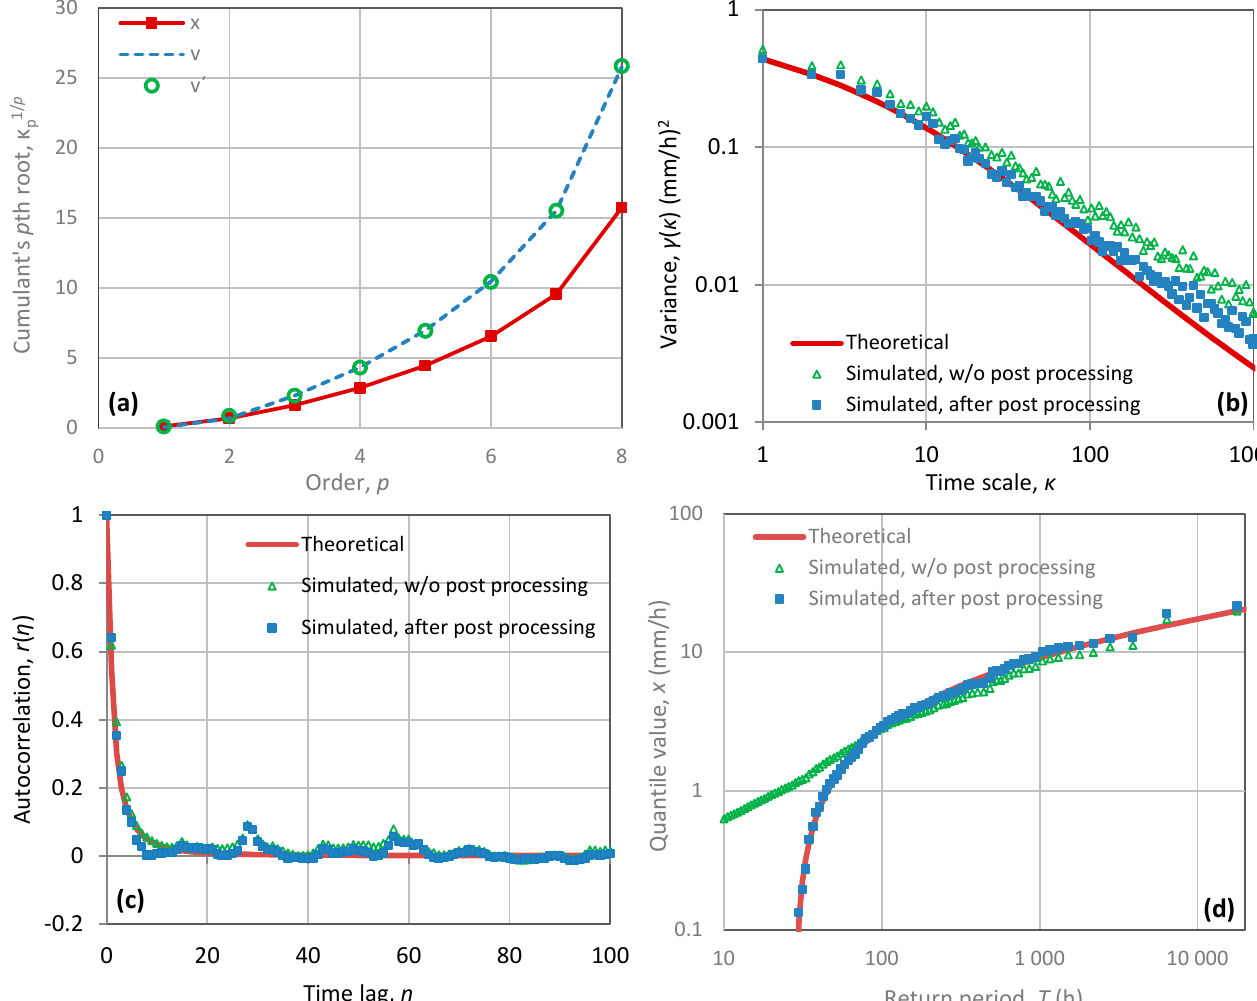
Figure 6. Graphical depiction of the results of the simulation application for a real-world case study for the precipitation process in Bologna at the hourly time scale, modelled as a persistent FHK process with Pareto distribution with discontinuity at zero: ( a ) cumulants; ( b ) climacogram; ( c ) autocorrelogram; ( d ) marginal distribution. For the approximation 𝑣 (cid:3099)(cid:4593) of 𝑣 (cid:3099) , we use a single Pareto distribution and allow a dis- continuity 𝑃 (cid:2869) at 𝑣′ = 0 . For mathematical consistency, the tail index of 𝑣 (cid:3099)(cid:4593) should neces- sarily be 𝜉 = 0.121 , so that the moments of order beyond 1/ ξ = 8.2 be infinite as is the case with the moments of 𝑥 (cid:3099) . The other parameters of the Pareto distribution of 𝑣 (cid:3099)(cid:4593) are calcu- lated by minimizing 𝑒 (cid:2870) in Equation (41), setting 𝑝 (cid:2923)(cid:2911)(cid:2934) = 8 , and are found to be 𝜆 ((cid:3049) (cid:4594) ) = 3.681, 𝑃 (cid:2869) ((cid:3049) (cid:4594) ) = 0.0171 , while the required shift of Equation (42) is negligible ( 𝑐 = 0 ). The cumulants of 𝑣 (cid:3099) (cid:4593) are also plotted in Figure 6a, where it can be seen that they are indistin- guishable from those of 𝑣 (cid:3099) and thus the achieved approximation is very good. Because of the very small value of 𝑃 (cid:2869)((cid:3049) (cid:4594) ) , a very large number of 𝑣 (cid:3099)(cid:4593) (98.3%) will be zero. The nonzero values will determine the locations of rainfall events, i.e., sequences of non-zero 𝑥 (cid:3099) . It is not reasonable to make these locations purely random and for this reason we devised the following procedure. A first model run is done with 𝑃 (cid:2869)((cid:3049) (cid:4594) ) = 1 (no zeros). Subsequently, we find a threshold 𝑐 (cid:2868) so that the fraction of values 𝑥 (cid:3099) that are greater than 𝑐 (cid:2868) equal 𝑃 (cid:2869) ((cid:3049) (cid:4594) ) . In a second model run we set 𝑣 (cid:3099) (cid:4593) = 0 at those τ where in the first run 𝑥 (cid:3099) < 𝑐 (cid:2868) . For the remaining τ , we generate 𝑣 (cid:3099)(cid:4593) from the continuous part of 𝑣 (cid:3099)(cid:4593) . This procedure allows clustering of the precipitation events, as typically happens in reality.